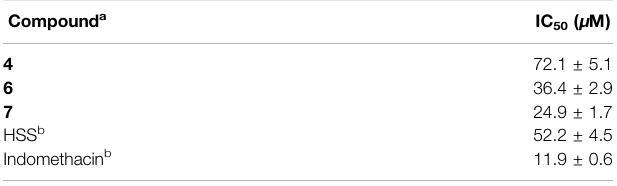
TABLE 4 | Inhibitory activity of compounds 1 – 9 against NO production in RAW 264.7